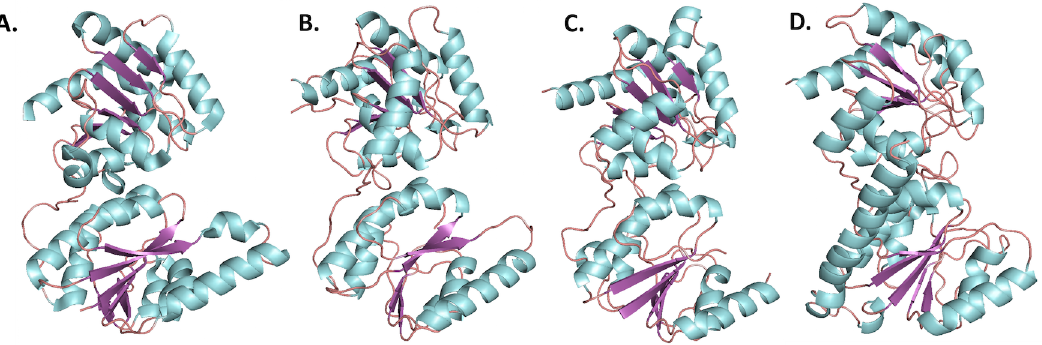
Figure 6. Structures of Heptosyltransferases (loops, α -helices, and β -sheets are colored salmon, cyan, and purple, respectively). ( A ) HepI from E. coli , PDB: 2H1H; ( B ) HepII from E. coli , PDB: 1PSW; ( C ) Computational model of HepIII from E. coli [51]; ( D ) Computational model of HepIV from E. coli